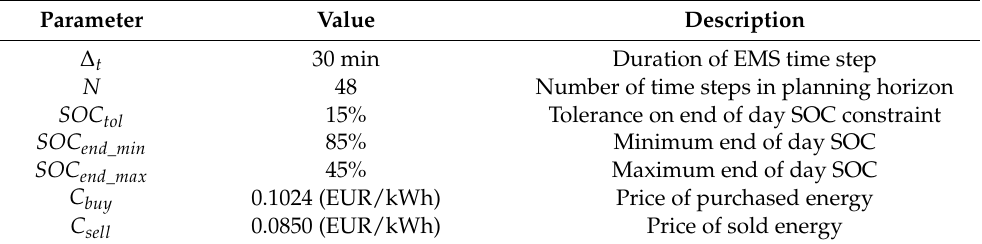
Table 1. Parameters of the energy management system (EMS) and of the energy market.